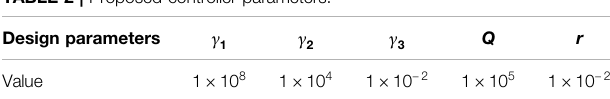
TABLE 2 | Proposed controller